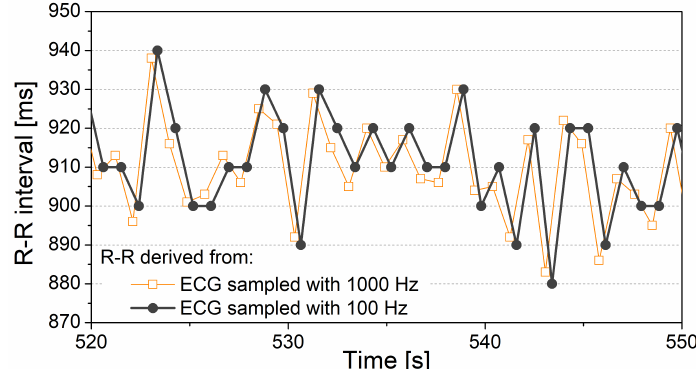
Figure 4. Peak position estimation: ( a ) Source signal (black line) sampled with 200 Hz (vertical lines); the error shift dT between the signal maximum (dashed line) and sample maximum (red line) is equal to 2 ms; dA is a corresponding amplitude change; ( b ) The interpolated samples (black line); gray lines show sin(x)/x interpolating functions; the error shift is reduced, but it still exists (dT = 0.1 ms) as the number of interpolating points is not infinite; ( c ) Source signal sampled with 1000 Hz; the error shift dT is equal to 0.4 ms.